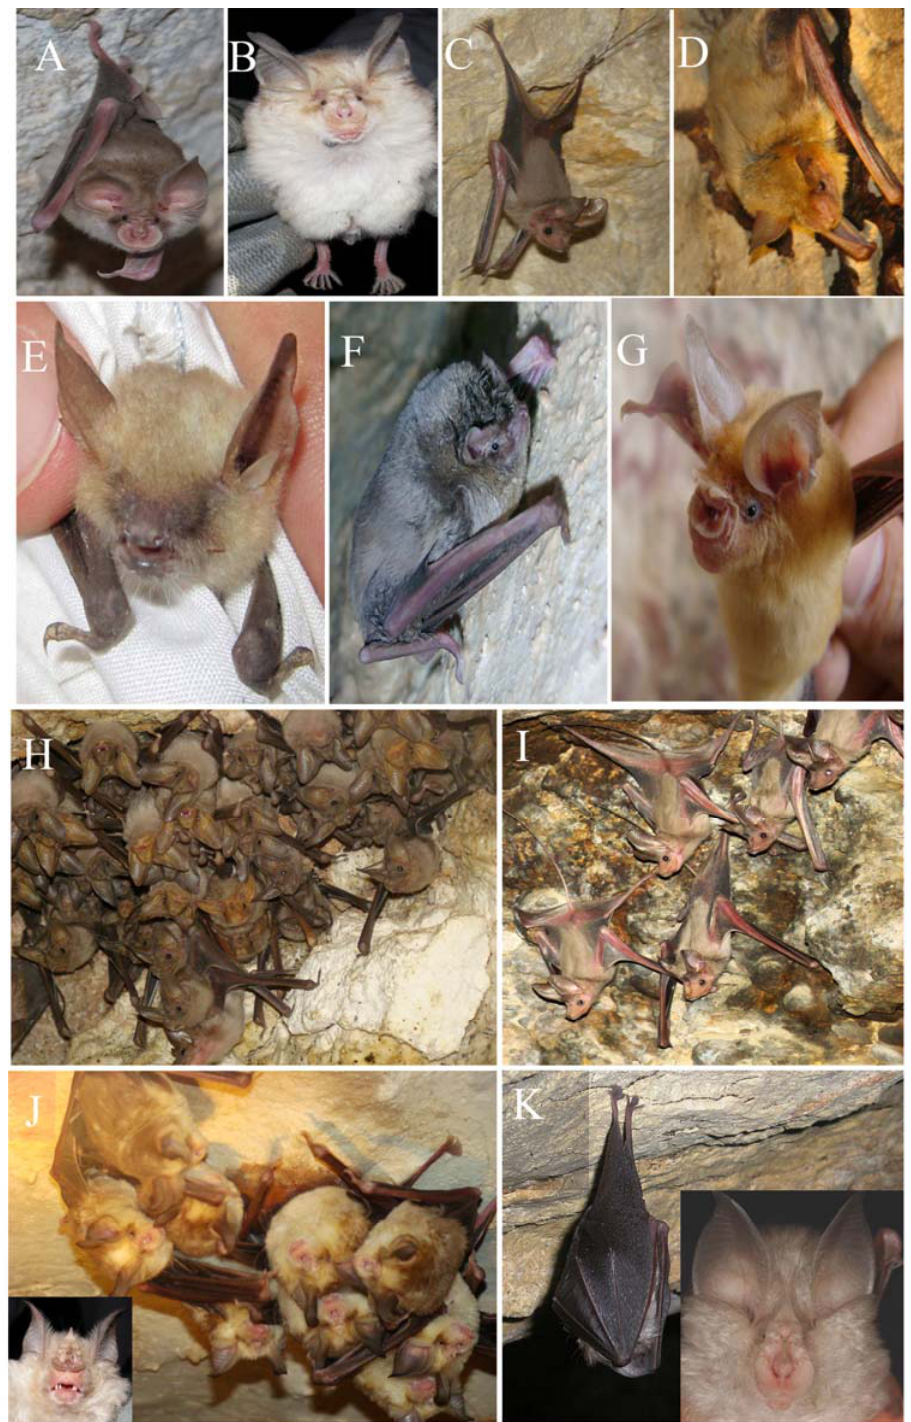
F IGURE 3. Collected species in this study in caves located in Table 1. A: Rhinolophus blasii , B: Rhinolophus euryale , C: Rhinopoma muscatellum , D: Myotis blythii , E: Myotis emarginatus , F: Miniopterus pallidus , G: Asellia tridens , H: Rhinopoma microphyllum , I: Rhinopoma hardwickii , J: Rhinolophus ferrumequinum , K: Rhinolophus hipposideros